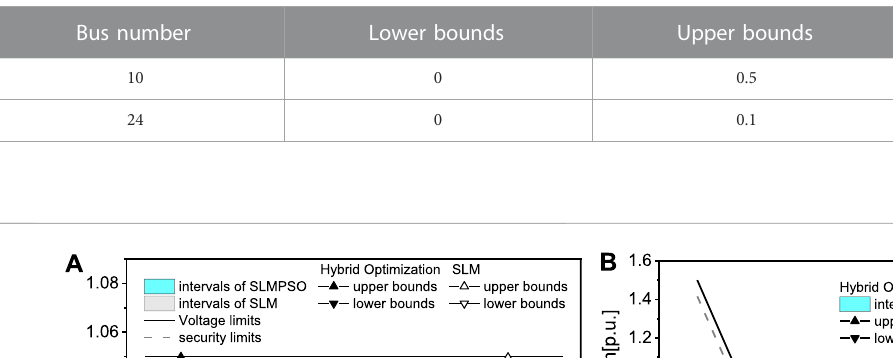
TABLE 2 Settings of capacitors in IEEE 30-bus system (p.u.).